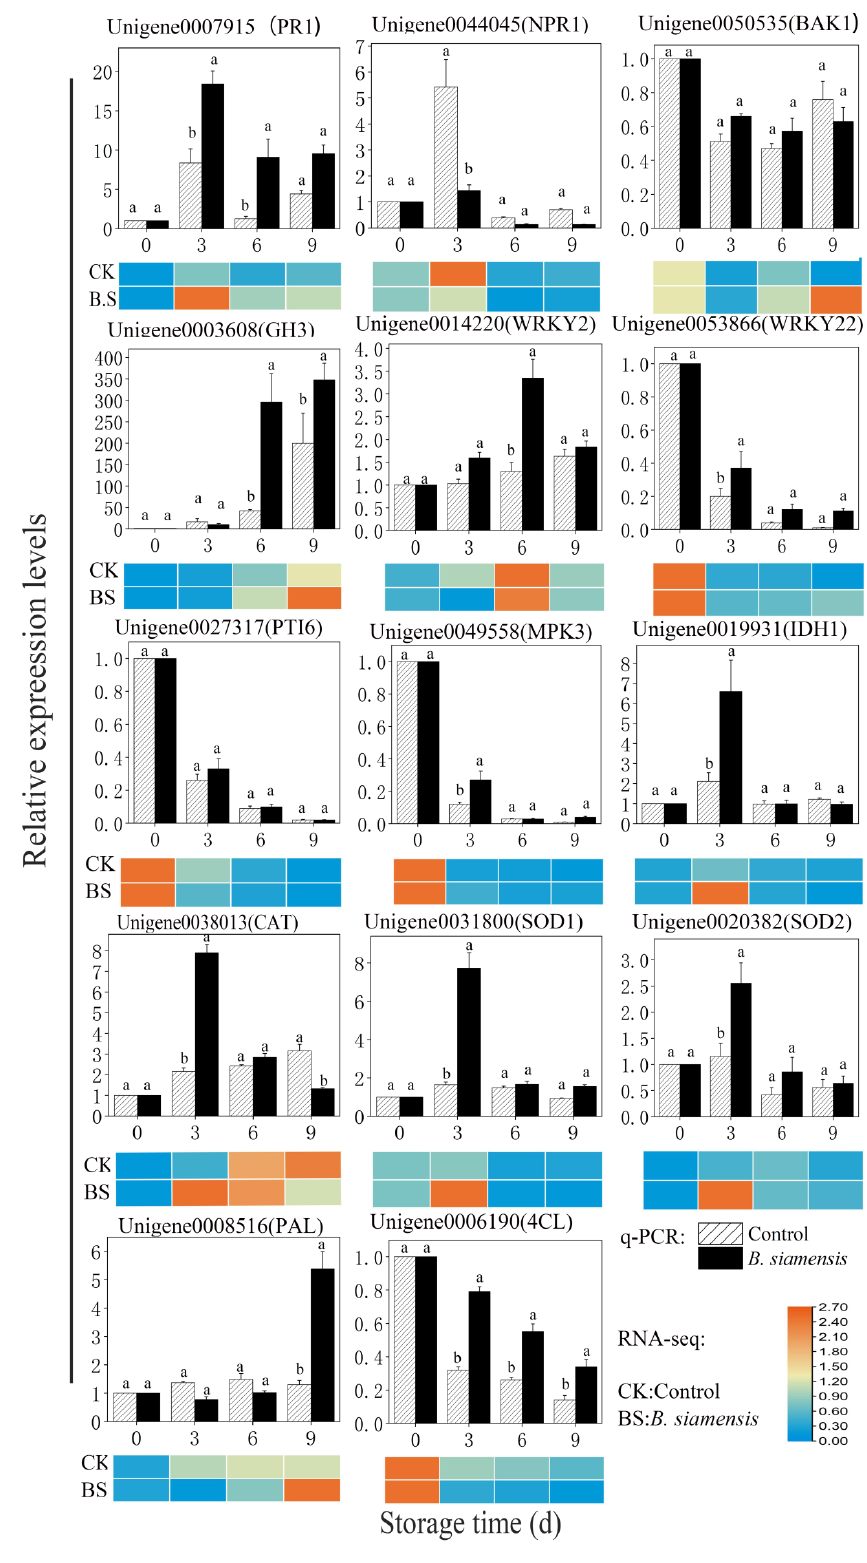
Figure 6. Expression pattern of 14 representative DEGs by qRT-PCR in mango fruits during storage. The expression levels of each unigenes are expressed as a ratio relative to 0 d of samples, which was set at 1. The heat map shows the change of the FPKM value of each gene. Error bars indicate standard errors of the means ( n = 3). Bars with different lower-case letters indicate significant differences based on a t -test at the p ≤ 0.05